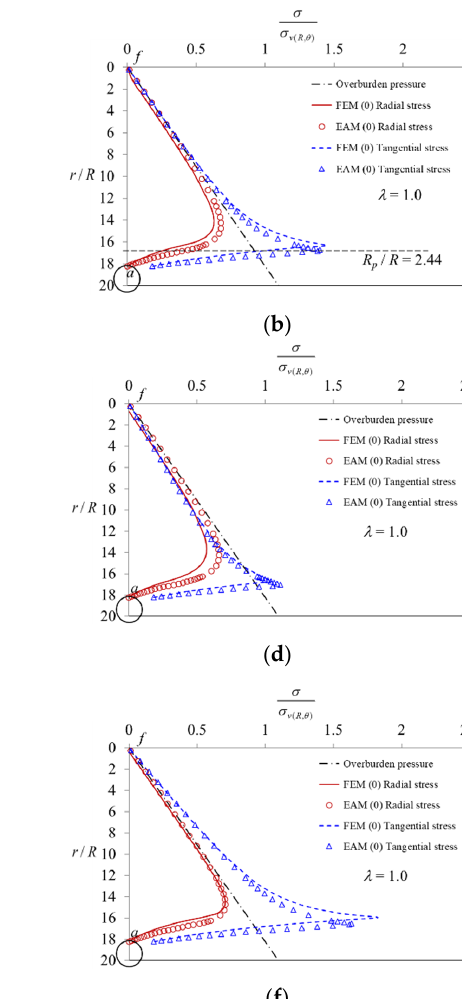
Figure 19. Ground reaction around the tunnel obtained by EAM and FEM in Case I ( θ = 0°) and Case III ( θ = 180°) with λ = 1.0 and K o = 0.8, and the distribution of radial displacements ( a ) in the elastic media, and ( b ) in the elastoplastic media.